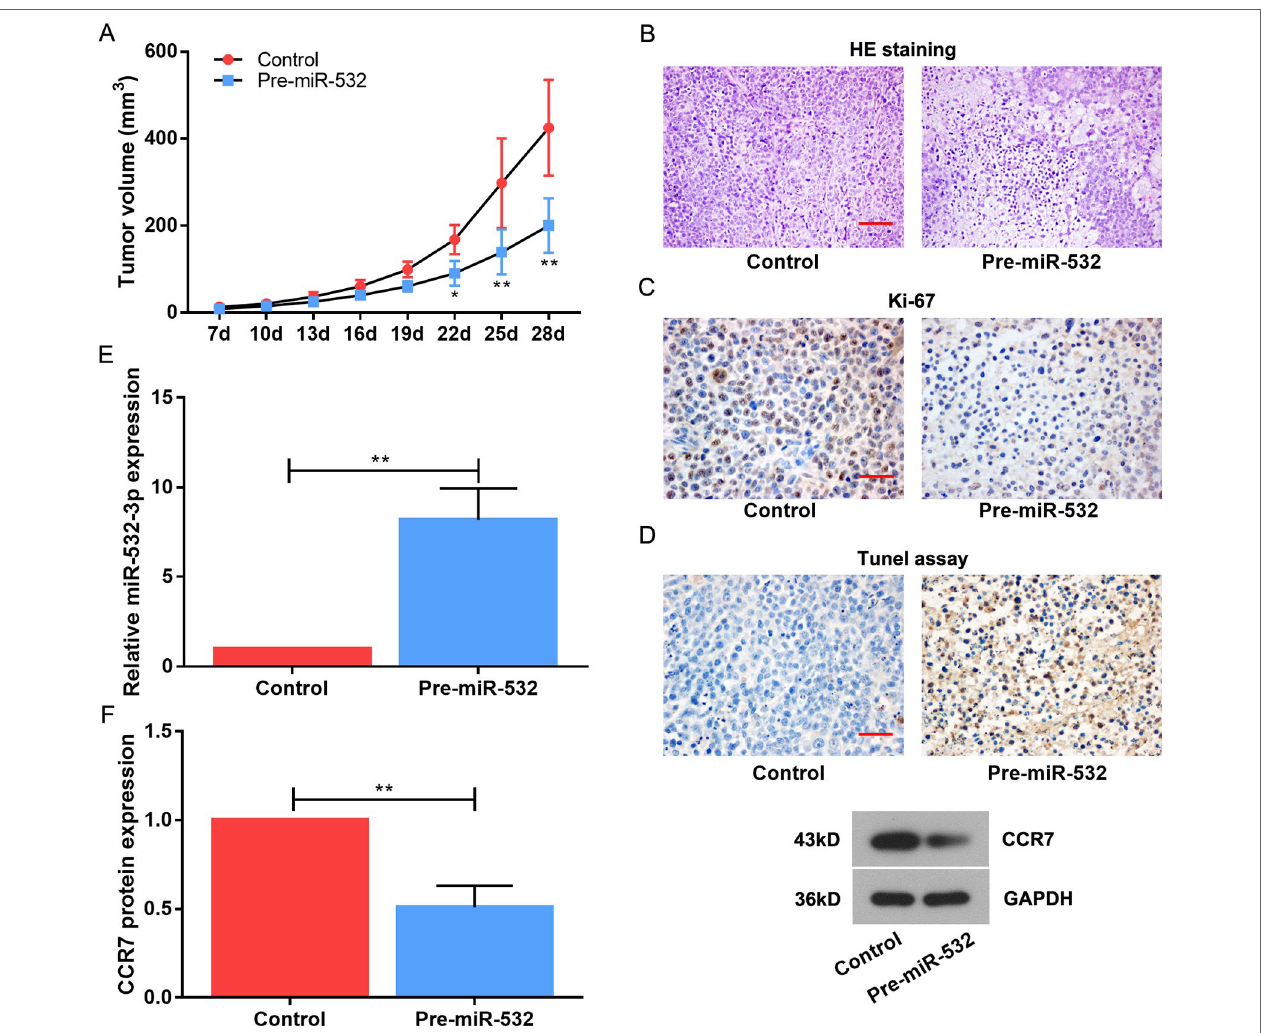
FIGURE 6 | MiR-532-3p hinders TSCC cell proliferation and simulates TSCC cell apoptosis in vivo . The tumor xenografts of CAL-27 in subcutaneously injected nude mice. (A) Data points are presented as mean tumor volume (mm 3 ). (B) HE staining was used to observe the tumor physiopathologic variation. Scale bar = 100 μM. (C) The immunohistochemistry assay on Ki-67. Scale bar = 50 μM. (D) The tunel assay on cell apoptosis. Scale bar = 50 μM. (E) MiR-532-3p expression was measured using real-time PCR. (F) The CCR7 level was reduced in pre-miR-532-overexpressed nude mice. * means p < 0.05; ** means p <